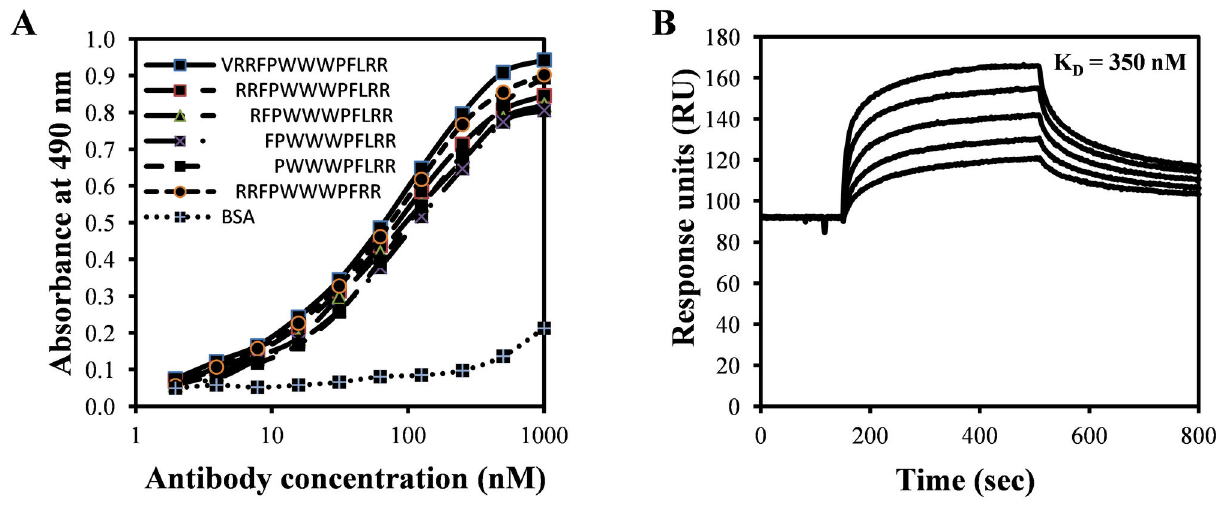
Figure 1. Binding analysis of 6C6D7. A. Direct binding ELISA demonstrating cross-reactivity of mAb 6C6D7 with N-terminal deletion analogs of tritrpticin. B. SPR sensorgram of binding of mAb (62.5-1000 nM) to K-tritrpticin on a CM-4 chip. doi: